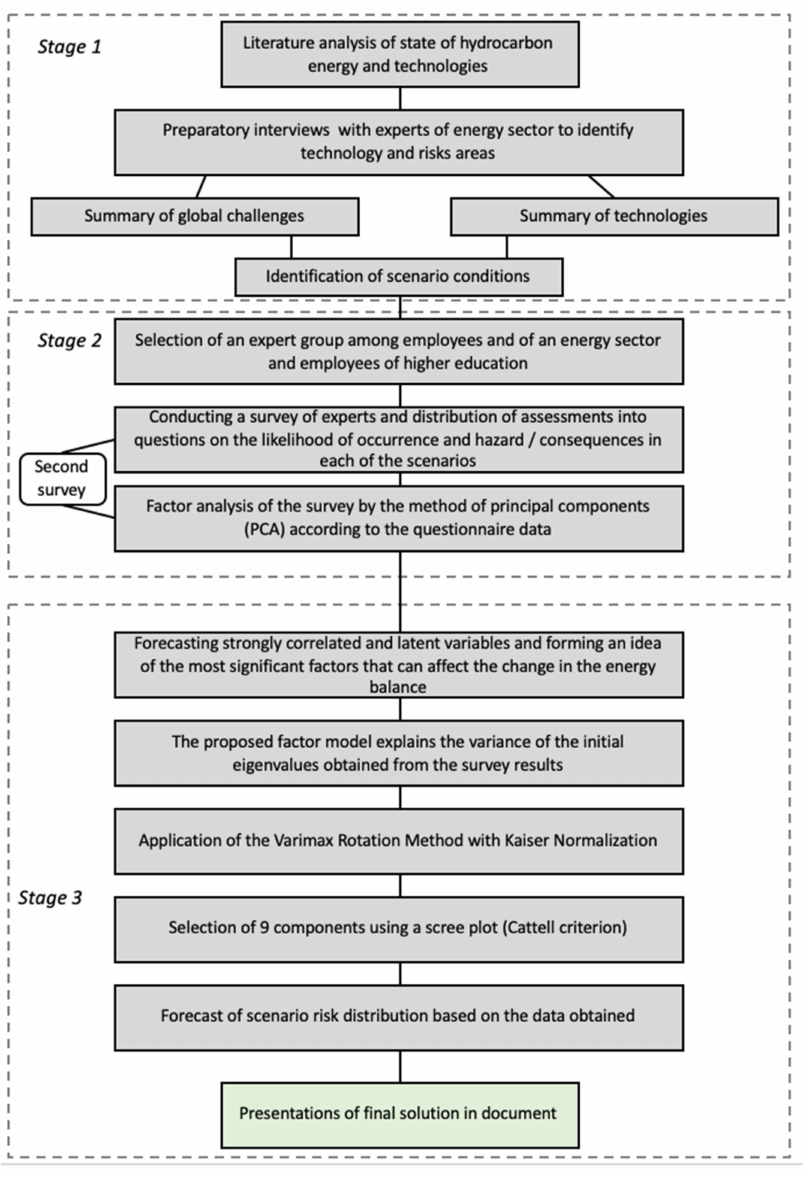
Figure 4. Steps of the